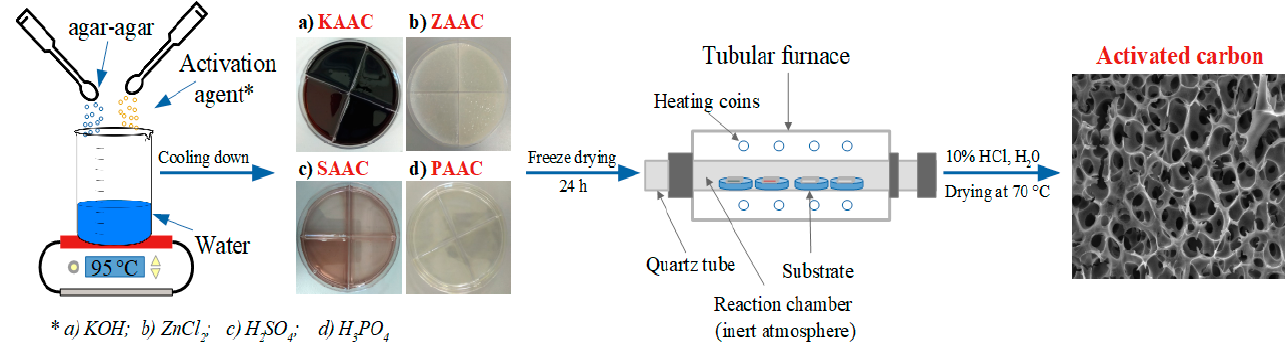
Figure 1. Preparation method of AC with four different activating agents: ( a ) KOH; ( b ) ZnCl 2 ; ( c ) H 2 SO 4 ; ( d ) H 3 PO 4 .